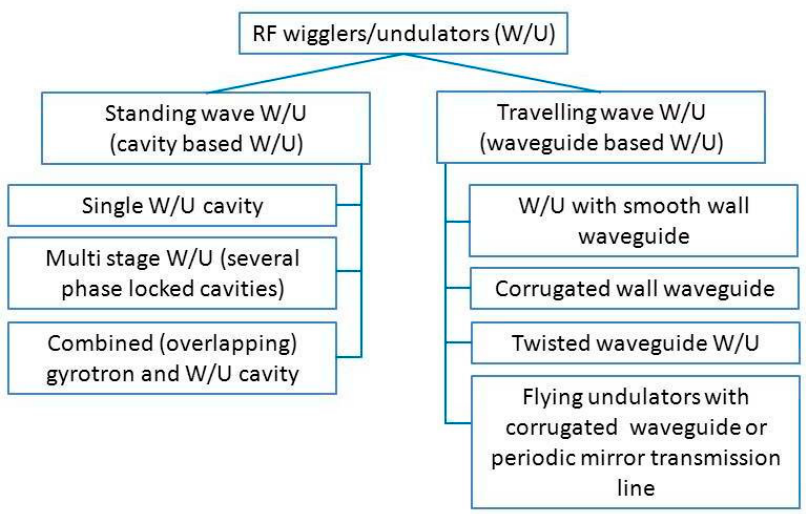
Figure 4. Classification of RF wigglers/undulators.